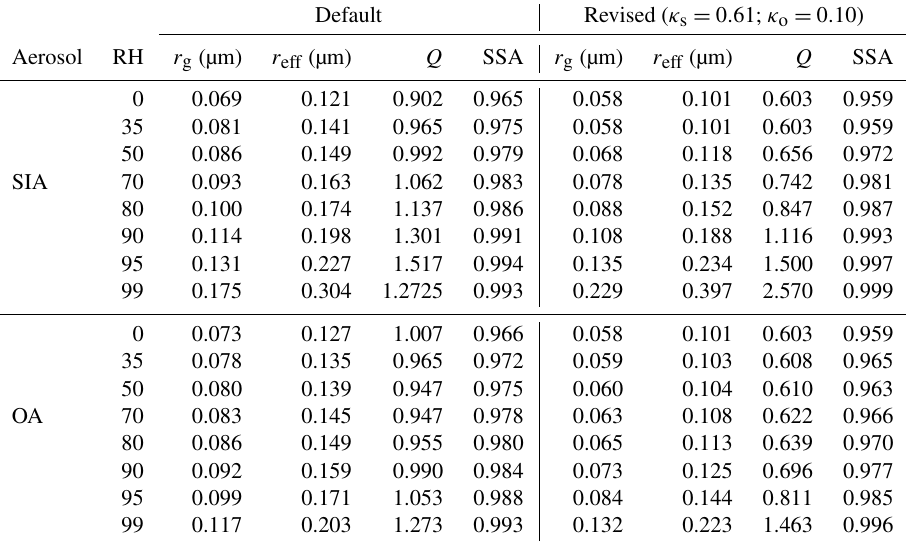
Table A1. Default and revised aerosol size and optical properties for secondary inorganic aerosols (SIA) and organic aerosols (OA) at 550nm at eight relative humidity values. Columns indicate geometric mean radius ( r g ), effective radius ( r eff ), extinction efficiency ( Q ), and single scattering albedo (SSA). κ s and κ o represent the hygroscopic growth parameters for SIA and OA, respectively.